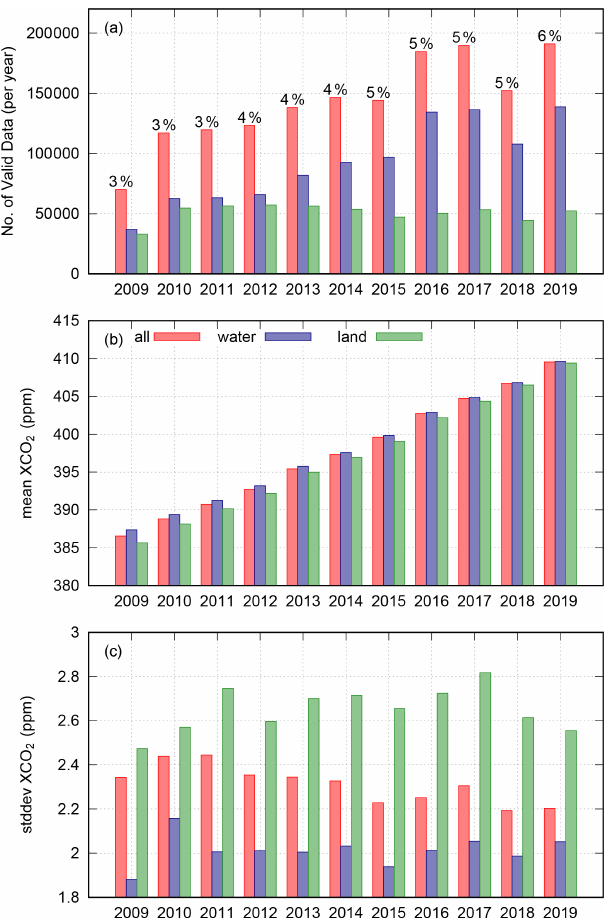
Figure 10. Statistics for valid GOSAT measurements (after pre- and post-processing filtering) for each year. Blue: measurements over water. Green: measurements over land. Red: all data. (a) Number of valid measurements, including the percentage of all originally available measurements. (b) Global mean XCO 2 . (c) Corresponding standard deviation.